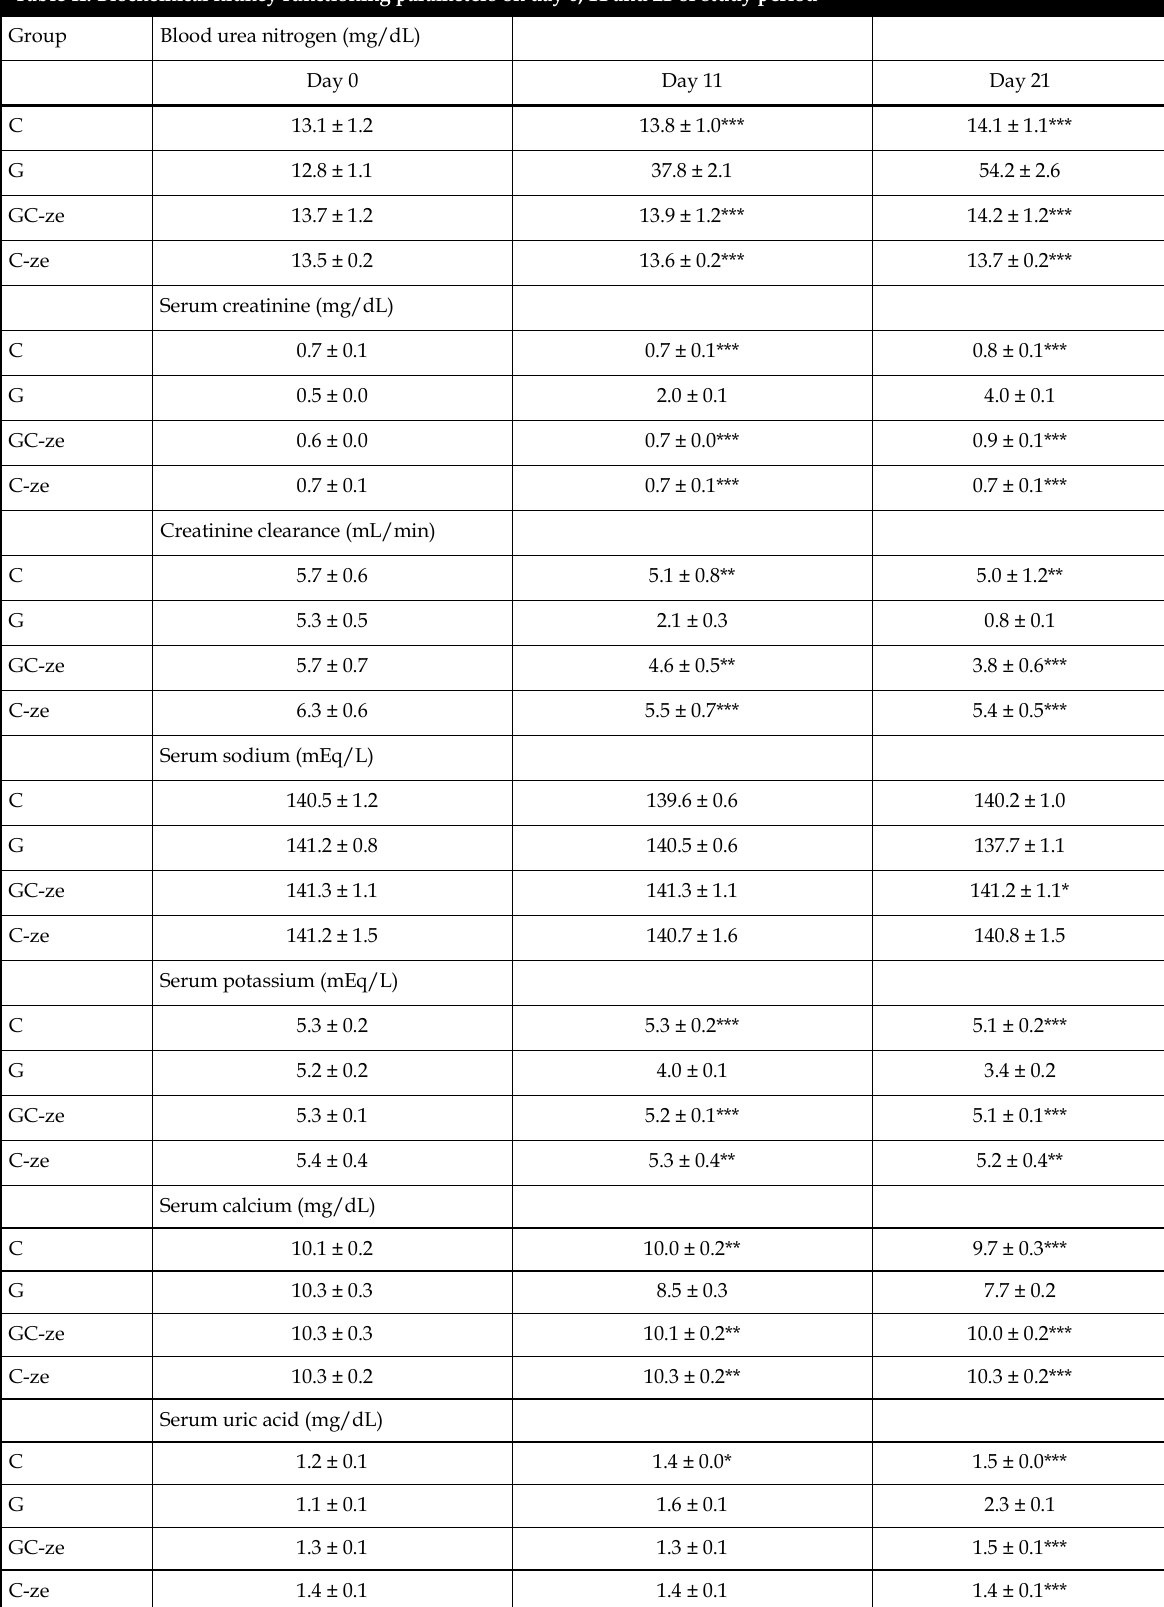
Table II: Biochemical kidney functioning parameters on day 0, 11 and 21 of study